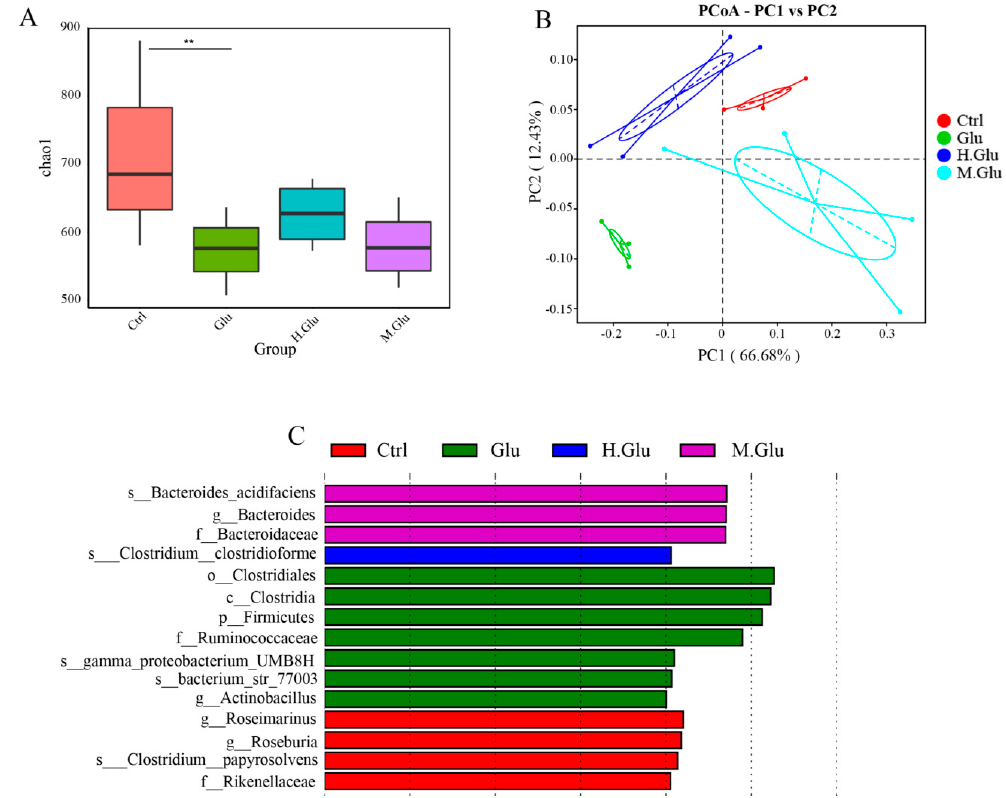
Figure 5. MGO regulates immune response by regulating the microbial composition of mice feces. Ctrl represents the control group and Glu, H.Glu, and M.Glu represent native glutenin, heated glutenin, and MGO-glutenin, respectively. Genomic DNA was extracted from the fecal samples taken from mice just before sacrifice. ( A ) Microbiota diversity of each group. ( B ) Principal coordinate analysis (PCoA) of each group. ( C ) LEfSe analysis microbiota diversity of each group. ** p <